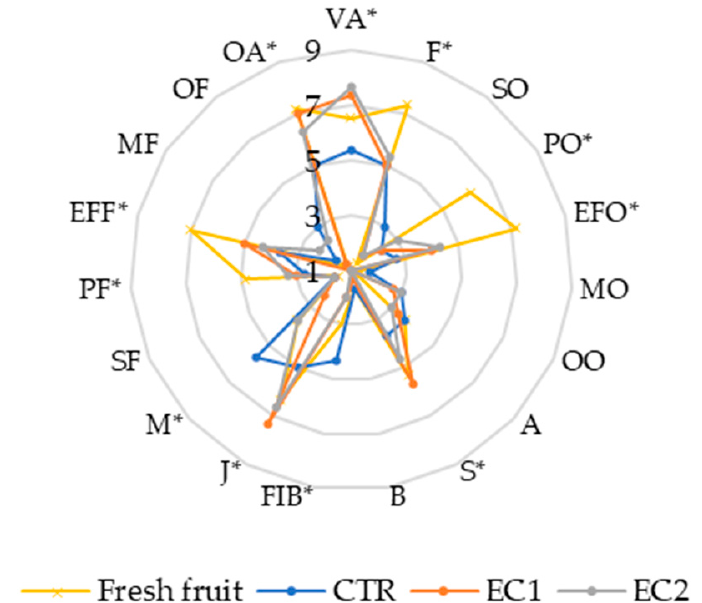
Figure 8. Sensory analyses of fresh-cut mango cubes after two days of cold storage. Descriptors: visual appearance (VA), firmness (F), sea odour (SO), peach odour (PO), exotic fruit odour (EFO), medicinal odour (MO), off-odour (OO), acidity (A), sweetness (J), bitterness (B), fibrousness (FIB), juiciness (J), mellowness (M), sea flavour (SF), peach flavour (PF), exotic fruit flavour (EFF), medicinal flavour (MF), off-flavour (OF), overall assessment (OA). Statistical differences ( p < 0.05) were highlighted by * on the descriptors.